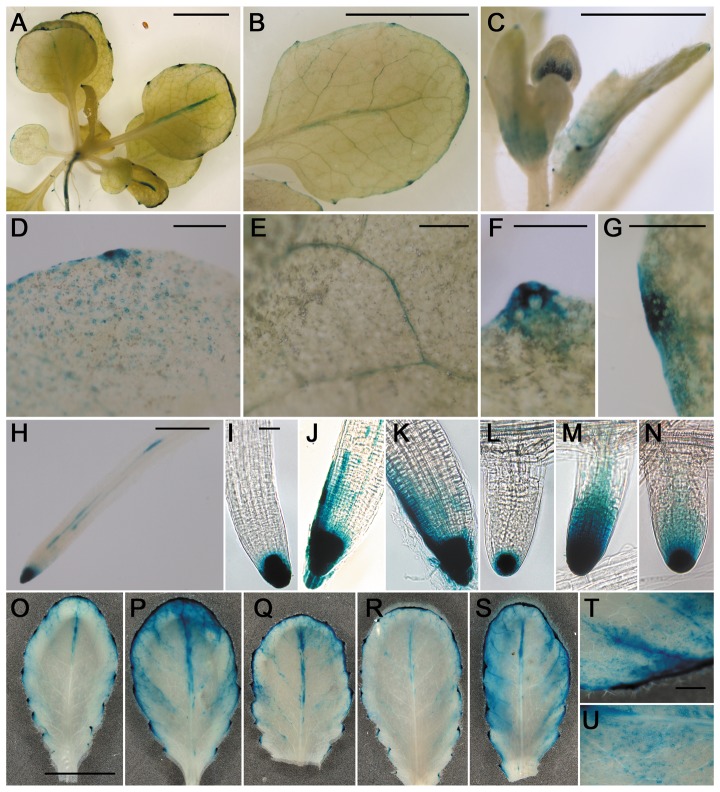

PLAT1 is expressed in the vasculature, hydathodes and stomata of aerial organs.
PLAT1 expression is reflected by GUS activity in plat1-1 mutant plants rescued by the PLAT1:PLAT1-GUS rescue/reporter construct (line GUS3-5). The PLAT1 promoter confers expression in the leaf vasculature (A, B, E), hydathodes (B, F, G), floral organs (C), stomata (D) and the primary root tip and root pericycle cells (H). PLAT1 expression in primary root tips, 24 h following transfer to control (I), 200 mM NaCl (J) or 1.5 µM ABA plates (K). PLAT1 expression in lateral root tips, 24 h following transfer to control (L), 200 mM NaCl (M) or 1.5 µM ABA plates (N). PLAT1 expression in fully expanded rosette leaf from 4-w-old seedling, control (O), following 24 h (P), or 48 h (Q) of treatment with 1.5 µM ABA and following 24 h (R), or 48 h (S) watering with 200 mM NaCl. Detail of rosette leaf showing expansion of expression domain in leaf mesophyll following 24 h ABA treatment (T), or 48 h watering with NaCl (U). Scale bar = 1 cm (A-C) and (O-S), 1 mm (D-H), (T), (U), 0.1 mm (I-N). n≥10.